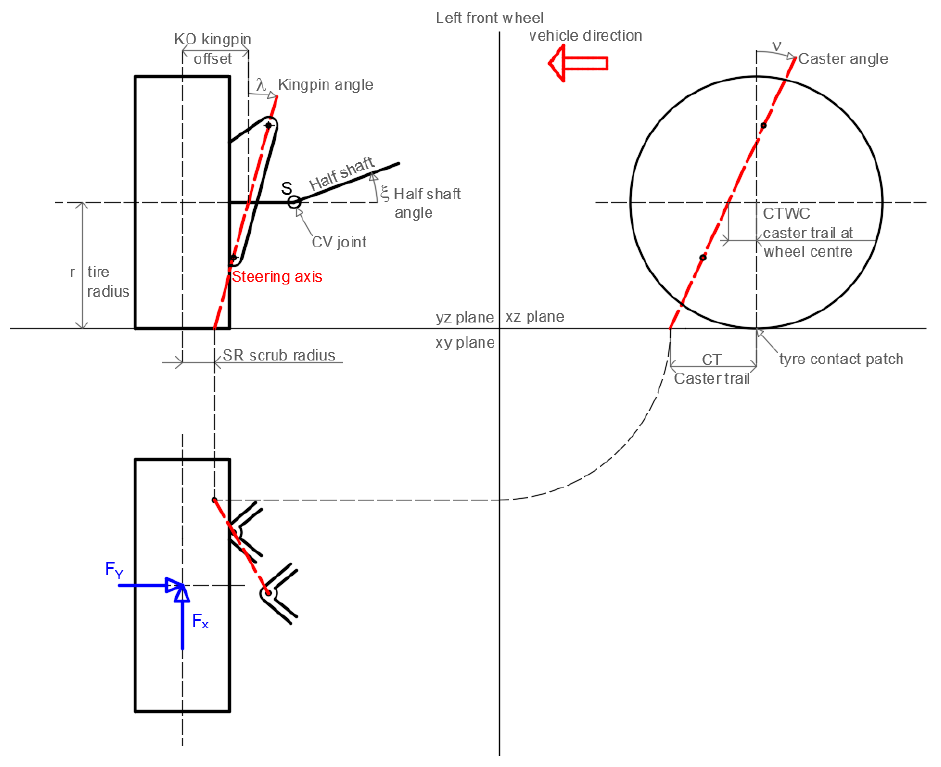
Figure 2. Steering geometry parameters in orthographic projection (SAE vehicle axis system).